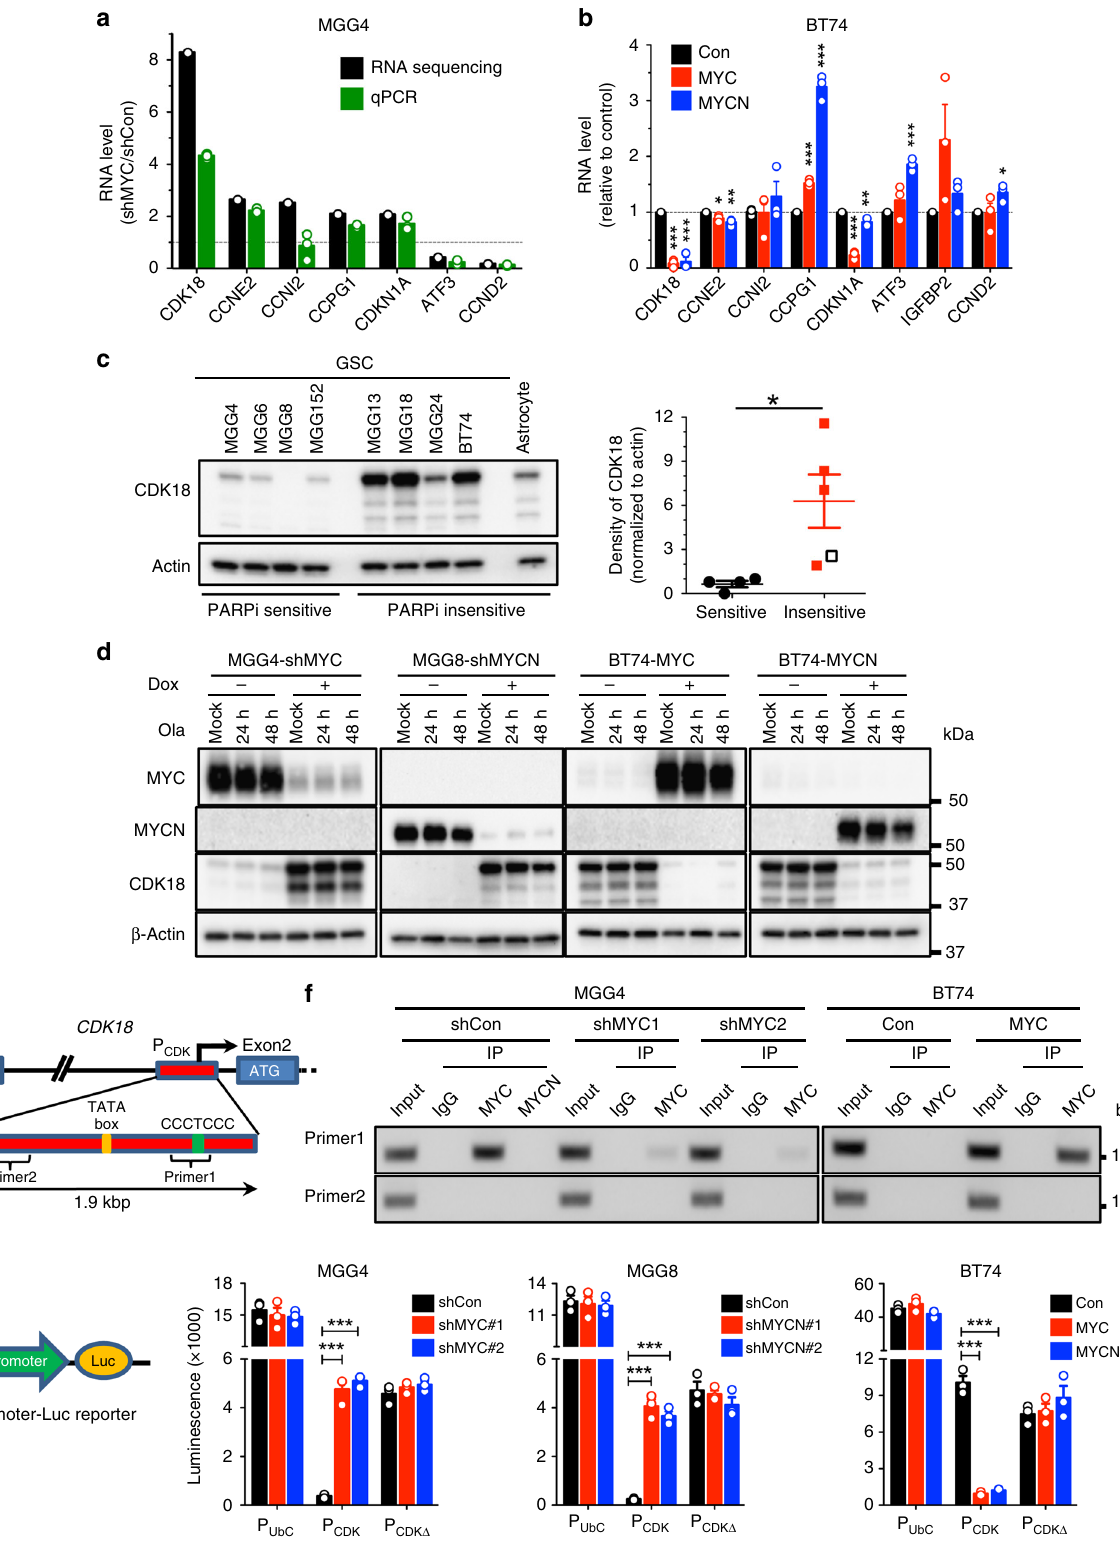
CDK18 overexpression increased and CDK18 silencing decreased BRCA2 and Rad51 foci – RPA foci-positive cells (Fig. 4f, g, Supplementary Fig. 9b, c). Because RPA foci only form during S and G2 phases 27 , this indicates that CDK18 promotes Rad51 focus formation during S and G2 phases. Even in the absence of PARPi, the proportion